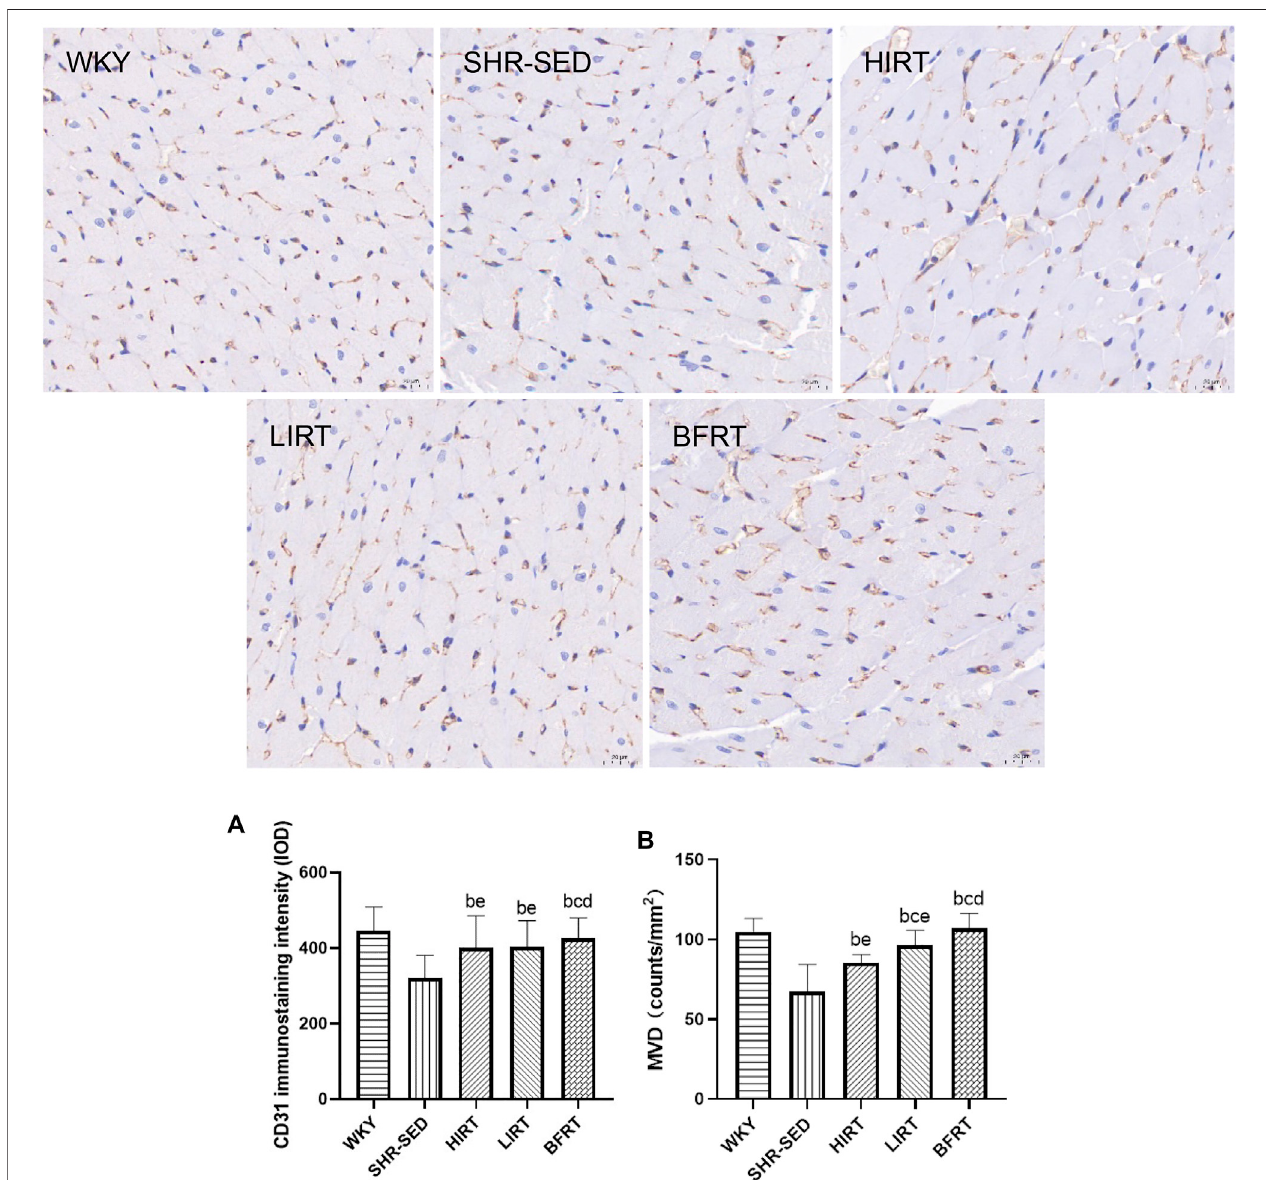
FIGURE 5 | Immunohistochemical staining of PECAM-1/CD31 in left ventricular tissues. All the pictures were taken at ×400 magni fi cation, Scale bars, 20 μ m (A) , CD31 immunostaining intensity; (B) microvessel density (MVD) of myocardium.